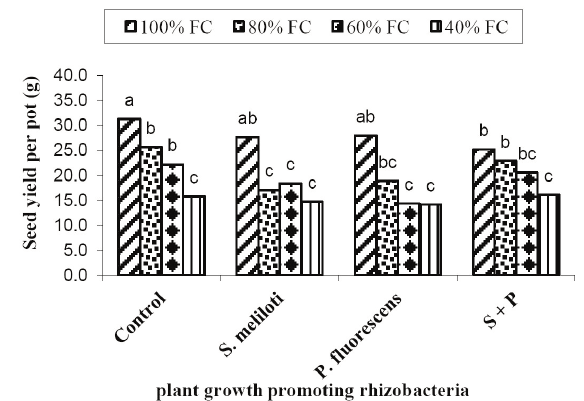
fig. 4 - Interaction of PGPR and soil water content on the seed yield of fenugreek.